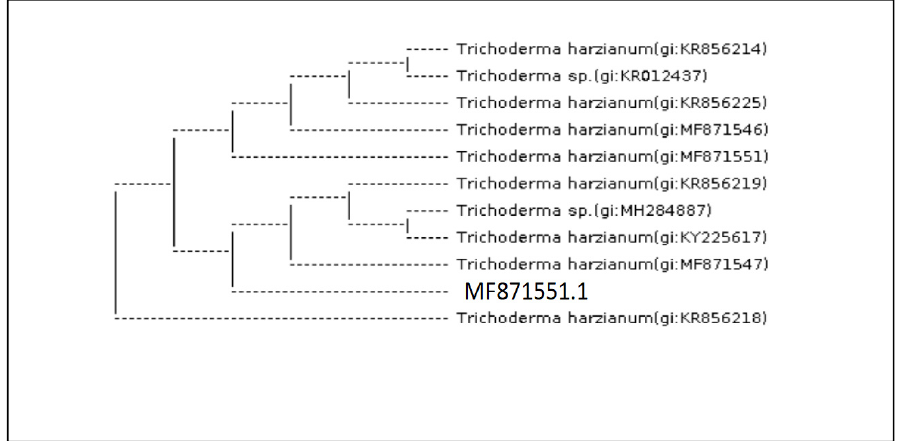
Figure 3. Trichoderma isolate (A (1) 2.1 T) (analysis of 18S rDNA of the T. harzianum (MF871551.1), with primers ITS4 and ITS5 in NCBI GenBank respectively).